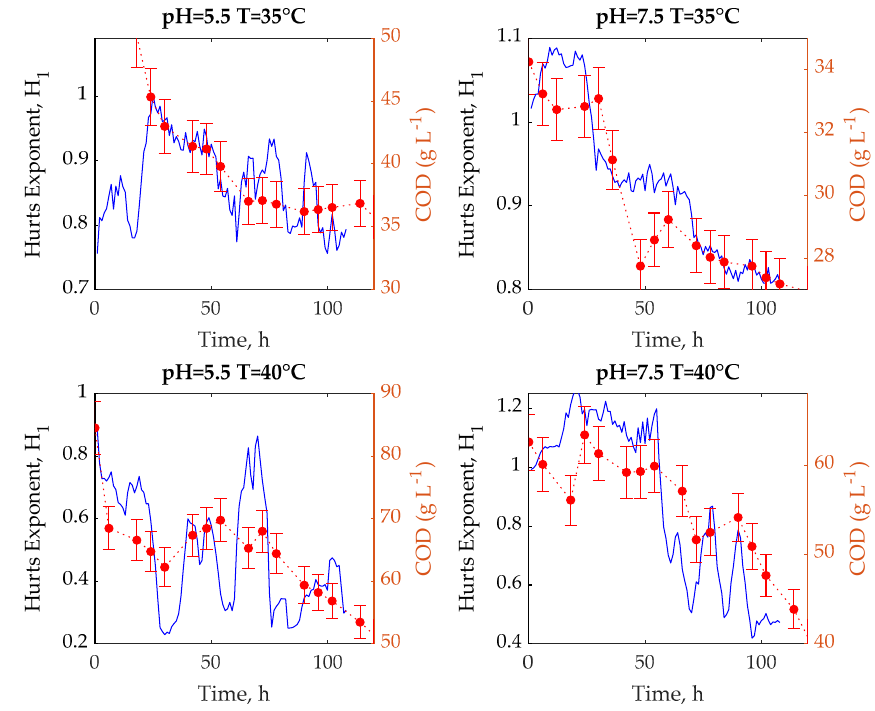
Figure 6. Correlations between Hd 1 and COD consumption measurements.